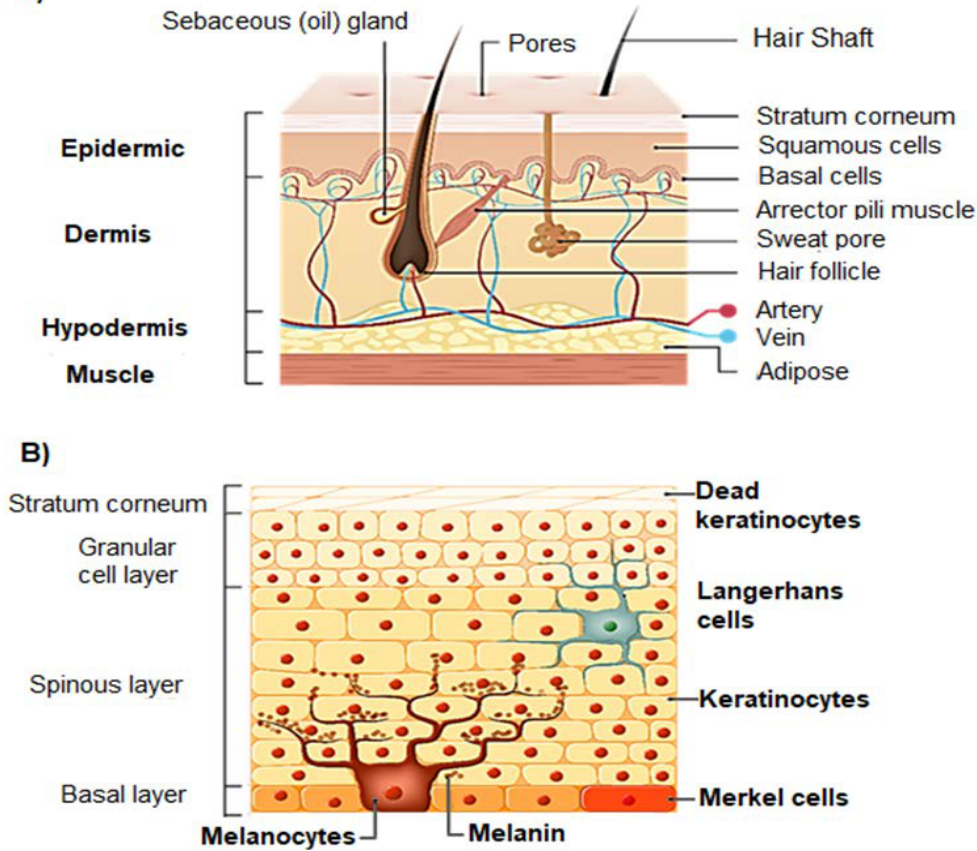
Figure 1. Structure of human skin ( A ) and structure of the epidermis ( B ).